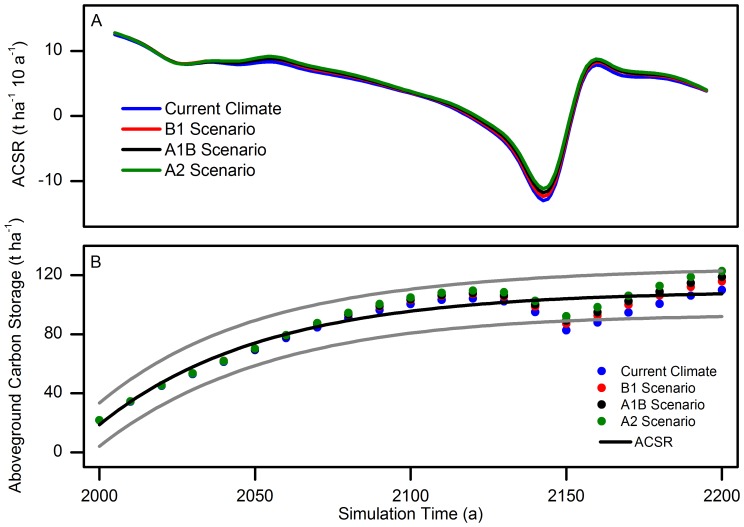
Total forest carbon sequestrations and its rate under various climate scenarios in simulation time.A: Forest total ACSR of different future climates. B: Forest aboveground carbon storage of different future climates. The black line means the average aboveground carbon storage of all possible future climates, and the grey lines indicate the forecasting interval of aboveground carbon storage with the confidence level of 95%.